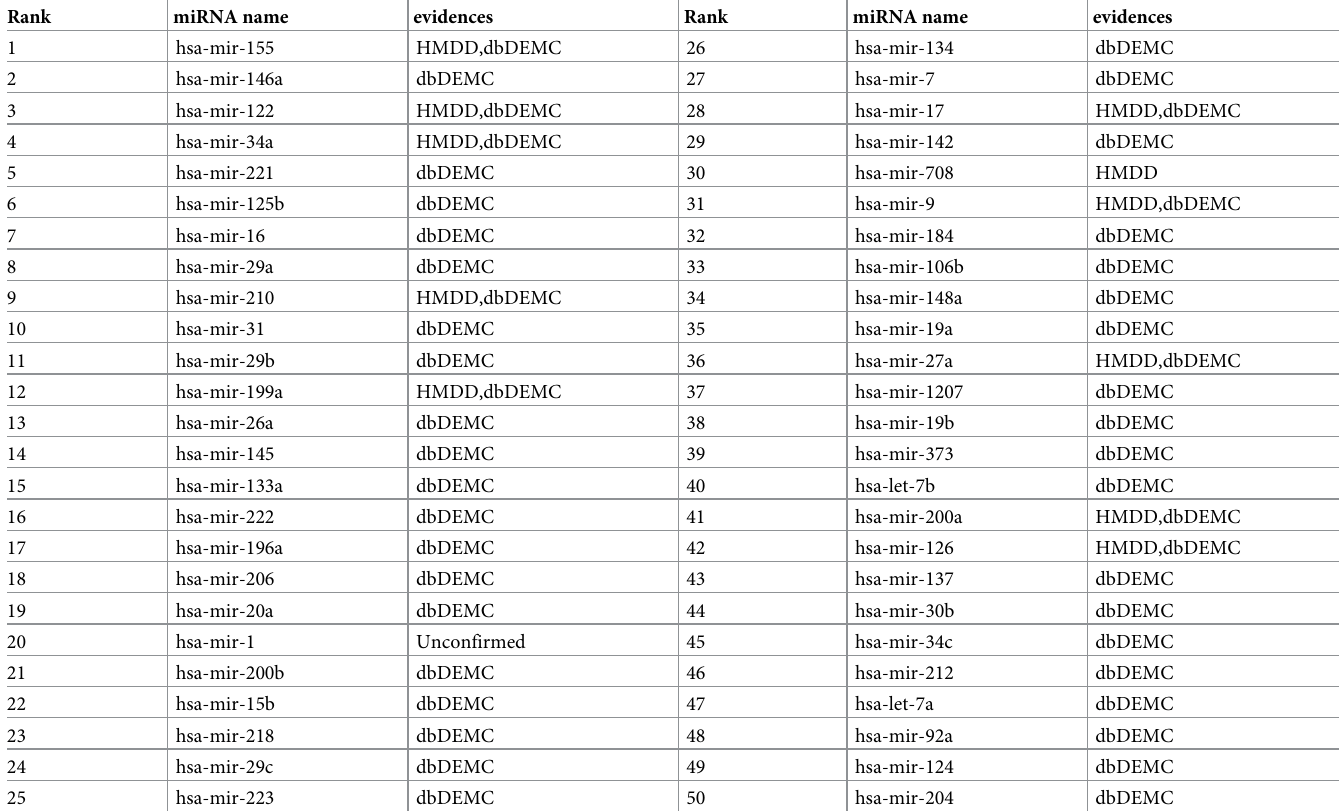
Table 2. The top 50 kidney neoplasm–related